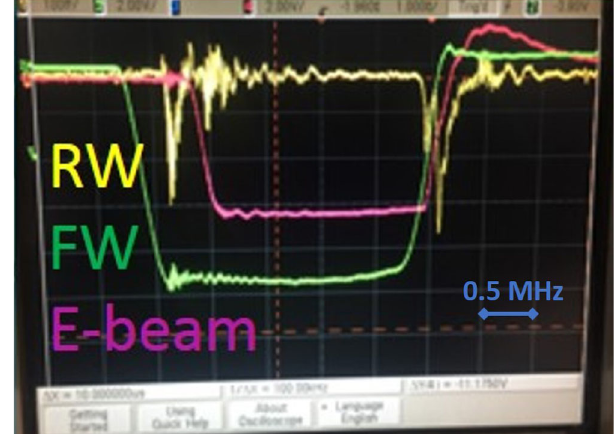
FIG. 18. The oscilloscope traces of the two monitored signals; the forward rf power (FW in green) from the magnetron and the reverse or reflected power (RW in yellow) from the linac. The beam current signal measured through the toroids at the linac exit is also displayed, in